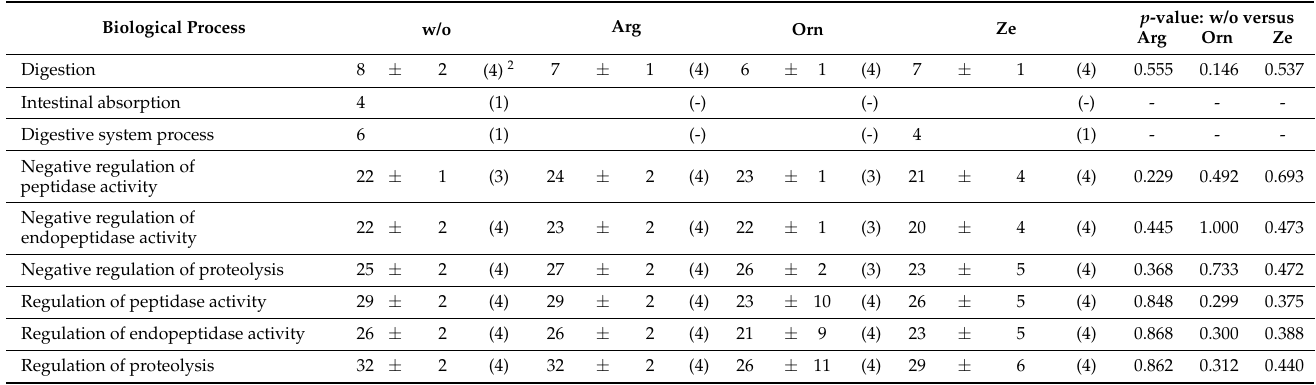
Table 3. Urinary proteins associated with biological processes 1 related to the nutrient metabolism and catabolic processes, detected in the urine of cats ( n = 4) fed a high-protein diet without (w/o) or with the supplementation of arginine (Arg), ornithine (Orn) or zeolite (Ze). Mean number of proteins ± standard